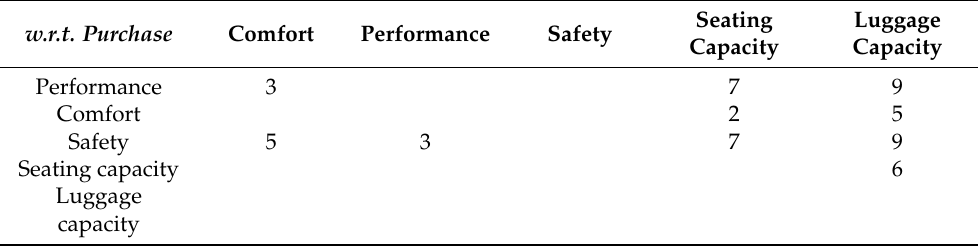
Table 7. Pairwise comparison matrix of sub-criteria of FUNCTIONALITY with respect to PUR- CHASE decision.